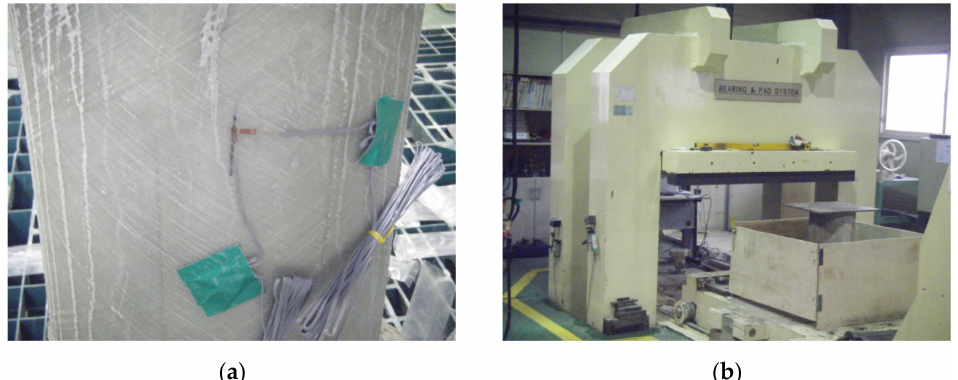
Figure 13. Compressive strength testing of the hybrid-CFFT: ( a ) gauge installation and ( b ) test- ing equipment.